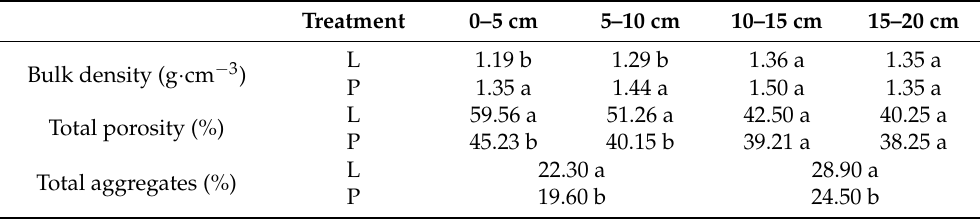
Table 4. Effects of continuous tillage at two fertilizer depths on soil physical properties.